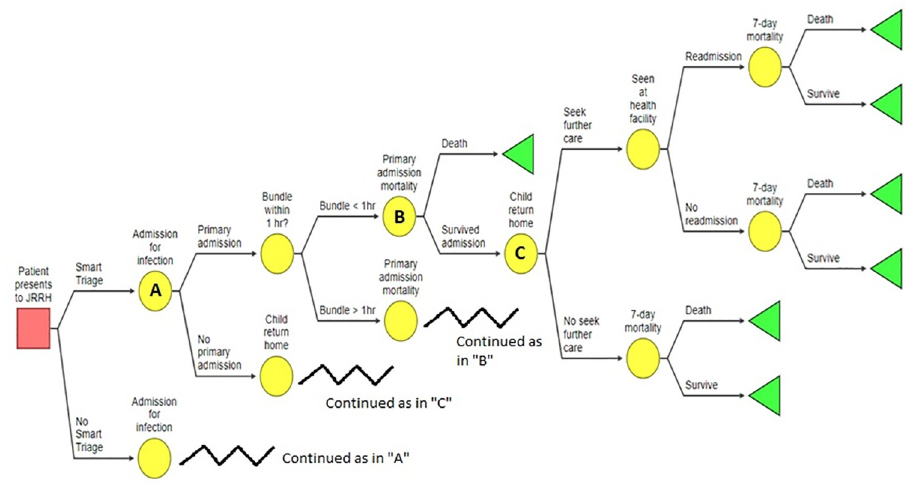
Fig 1. Decision analytic model of post-triage and post-discharge care pathways, used for the cost-effectiveness analysis of Smart Triage.